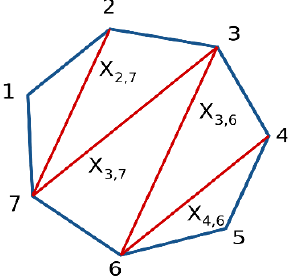
Figure 1 . Planar